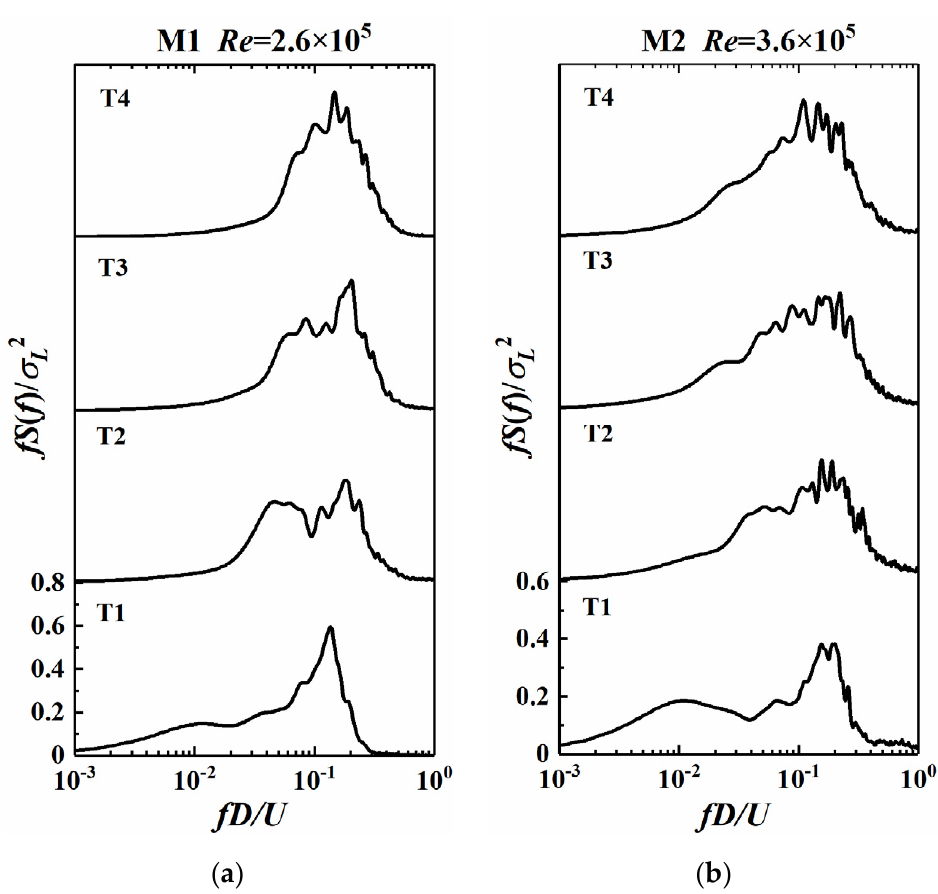
Figure 14. Power spectrum of the local lift coefficient at 0.5H of models under different wind fields. ( a ) M1; ( b )